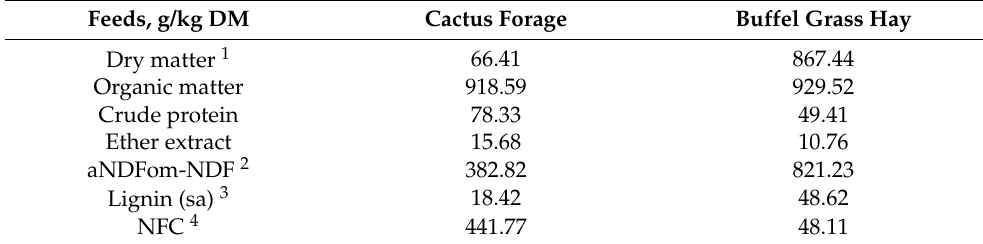
Table 1. Chemical composition of cactus forage and buffel grass hay. Feeds, g/kg DM Cactus Forage Buffel Grass Hay Dry matter 1 66.41 Organic